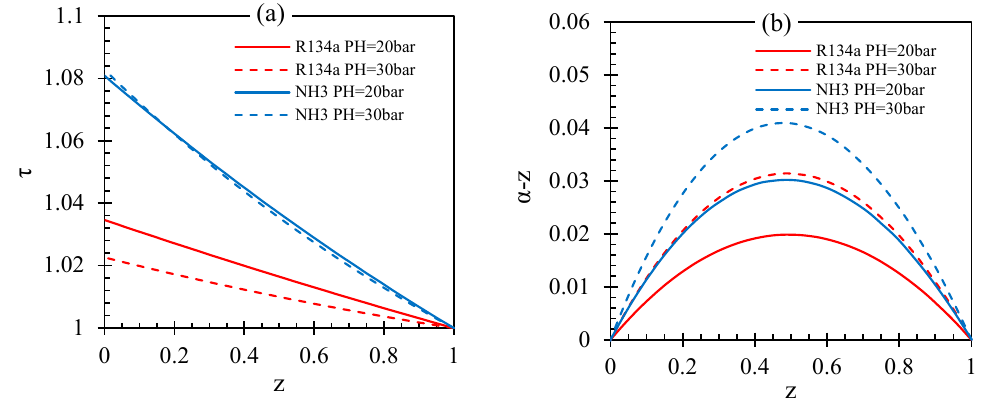
Figure 8. Temperature at the end of the compression stroke (a) and relative efficiency (b) for R134a and ammonia as a function of the relative work. Table 2. Heat capacity ratios.